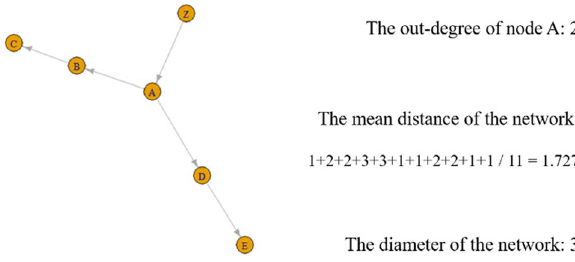
Figure 1. A small directed